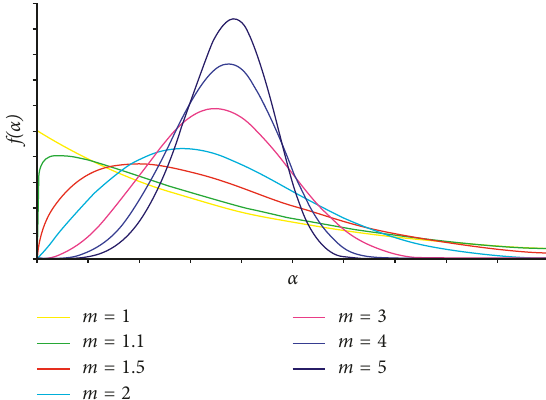
Figure 3: Weibull’s distribution of the mechanical parameters of materials with different heterogeneity m value